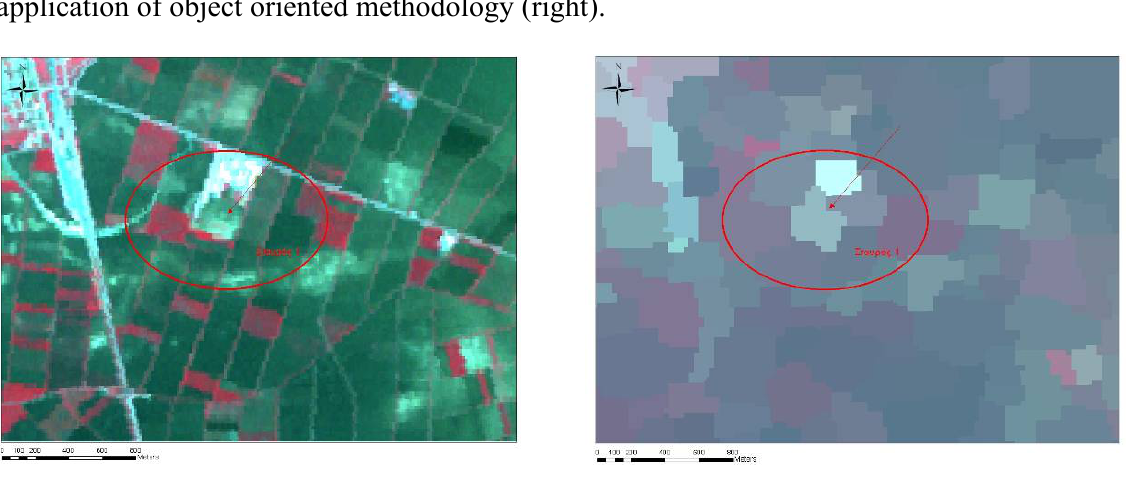
Figure 17. RGB – 3,2,1 ASTER image – Stauros 1 Settlement (left). Stauros 1 after the application of object oriented methodology